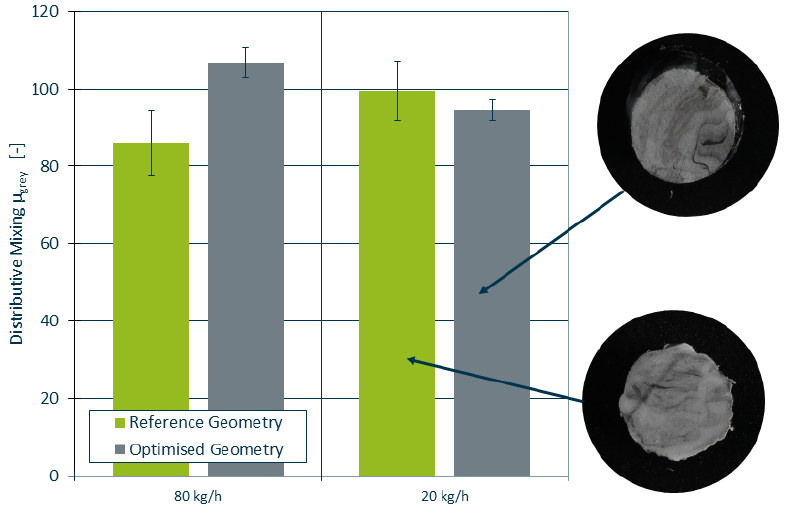
Figure 13. Distributive mixing capabilities of the reference and optimised mixer. High values of µ grey are indicative of improved